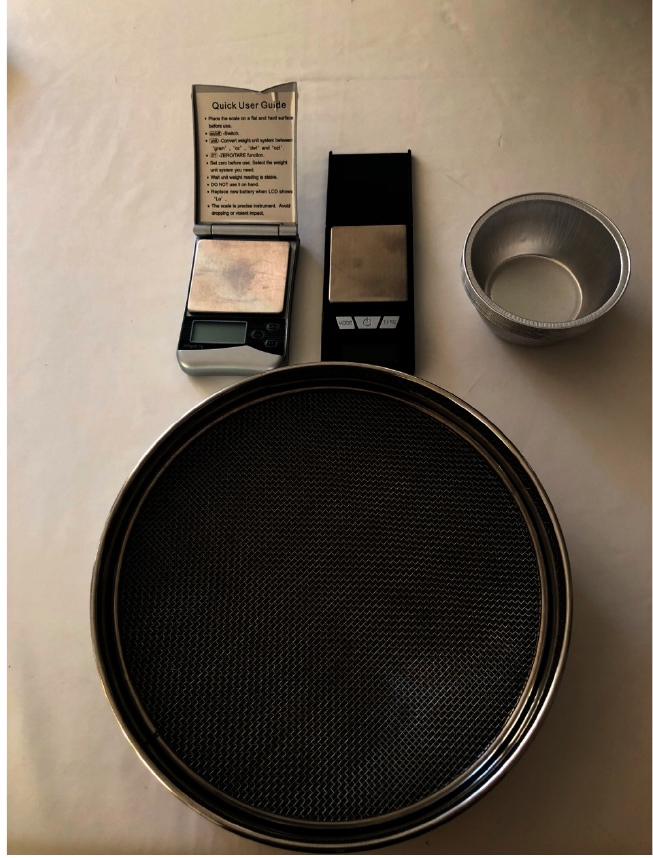
Figure 1. Precision scale and sieve used to collect and weight the specimens.